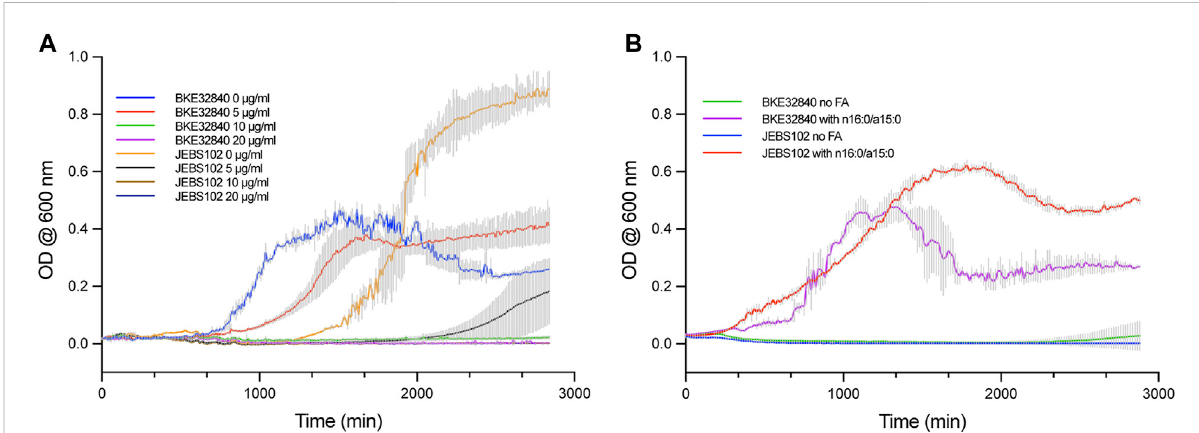
FIGURE 1 Comparativegrowthassayswereconductedin96-wellformatbetween B.subtilis strainJEBS102( Em r Cm r trpC2 Δ fadNlacA::P xyl -dcas9amyE:: P veg -sgRNA ( fabF )), and the original strain BKE32840 ( trpC2 Δ fadN::erm ). (A) Cell growth was compared between the two strains in M9-Gluc, 5 mM L-tryptophan, 1% ( w/v ) D-xylose, plus the addition of 0, 5, 10, and 20 μ g/ml of cerulenin. In the absence of cerulenin, BKE32840 displayed a shorter lag time but ca. 2-Fold lower cell densities that JEBS102. A cerulenin concentration of 5 μ g/ml did not inhibit growth of BKE32840 but signi fi cantly inhibited JEBS102 with low turbidity developing in some wells after 37 h of incubation. Higher concentrations of cerulenin blocked growth of both strains. (B) B. subtilis strains JEBS102 and BKE32840 were grown in M9-Gluc (with 5 mM L-tryptophan), 1% ( w/v ) D-xylose, 20 μ g/ml cerulenin, 5 g/L FA-free BSA and either with or without the addition of 8 μ g/ml each of n 16:0 and a 15:0. The addition of FAs rescued the growth of both strains with JEBS102 displaying a slower rate of growth but higher overall cell densities. No growth occurred in the absence of exogenous FAs. Each data point represents the mean of three biological replicates with error reported as ± standard deviation.